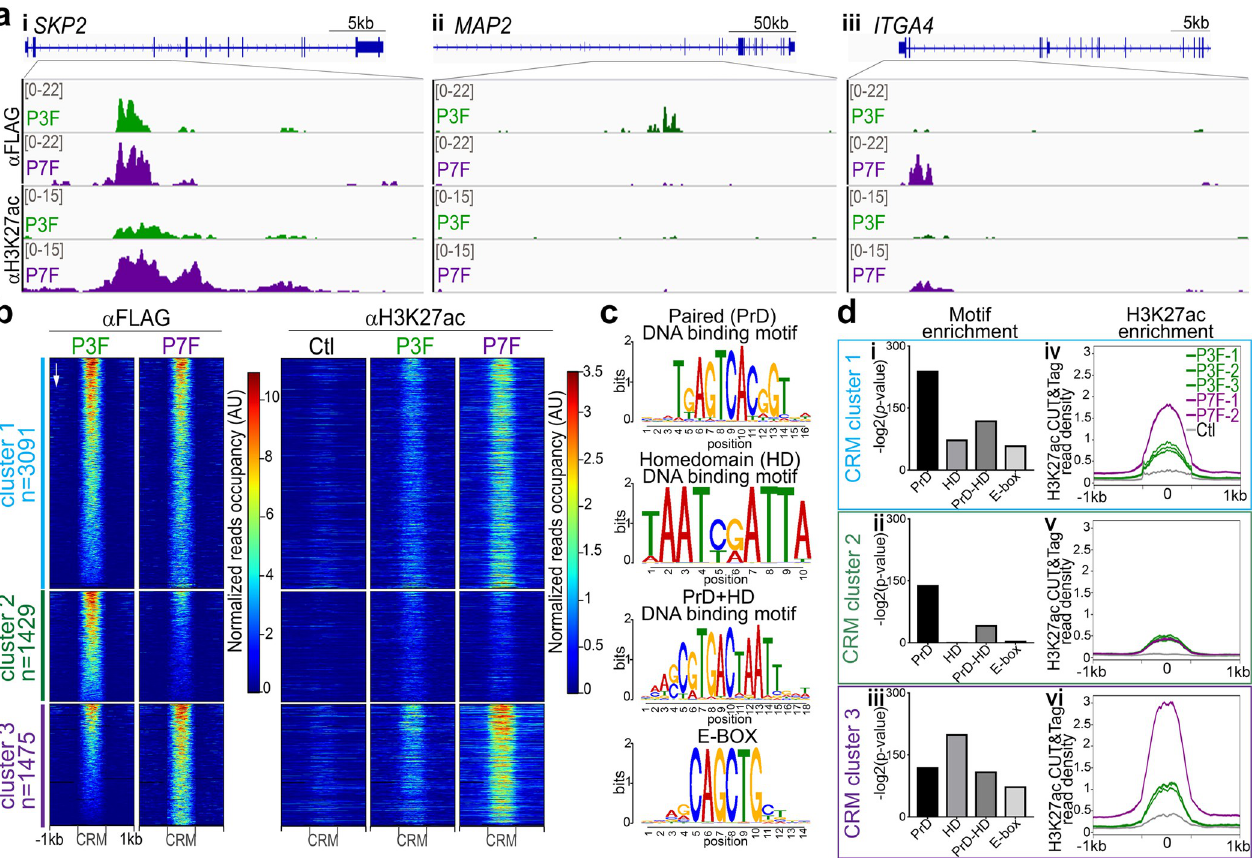
Fig 1. PAX3-FOXO1 and PAX7-FOXO1 recruitment to the genome and impact on H3K27ac deposition. (a) Examples of IGV tracks showing normalized FLAG and H3K27ac CUT&Tag reads distribution in cells expressing either PAX3-FOXO1 (P3F) or PAX7-FOXO1 (P7F) 48h post-DOX treatment. Scales in counts per million (CPM). (b) Heatmaps of normalized FLAG and H3K27ac CUT&Tag signals obtained in control (Ctl), PAX3-FOXO1 (P3F) and PAX7- FOXO1 (P7F) expressing HFF 48h post-DOX treatment in three cis -regulatory modules (CRMs) clusters. The ranking of the CRMs is the same on all heatmaps and follows the occupancy levels of PAX3-FOXO1 in descending order (arrow). Cluster 1 contains CRMs onto which the occupancy rate of PAX3-FOXO1 and PAX7-FOXO1 are similar. Cluster 2 CRMs are more bound by PAX3-FOXO1 than PAX7-FOXO1, and cluster 3 is the converse of cluster 2. (c) Logos of position weight matrices of DNA recognition motifs for the PAX paired (PrD) and/or homeodomain (HD) and by bHLH TFs (E-BOX). (d) Left panels: Enrichment for DNA binding motifs displayed in c in the CRMs belonging to the clusters defined in (b) (bars: -log2( p -value)). Right panels: Average profiles of normalized H3K27ac CUT&Tag signals at CRMs belonging to the clusters defined in (b) in the indicated control (Ctl), P3F or P7F cell lines. Note that the two P7F purple curves are superimposed.